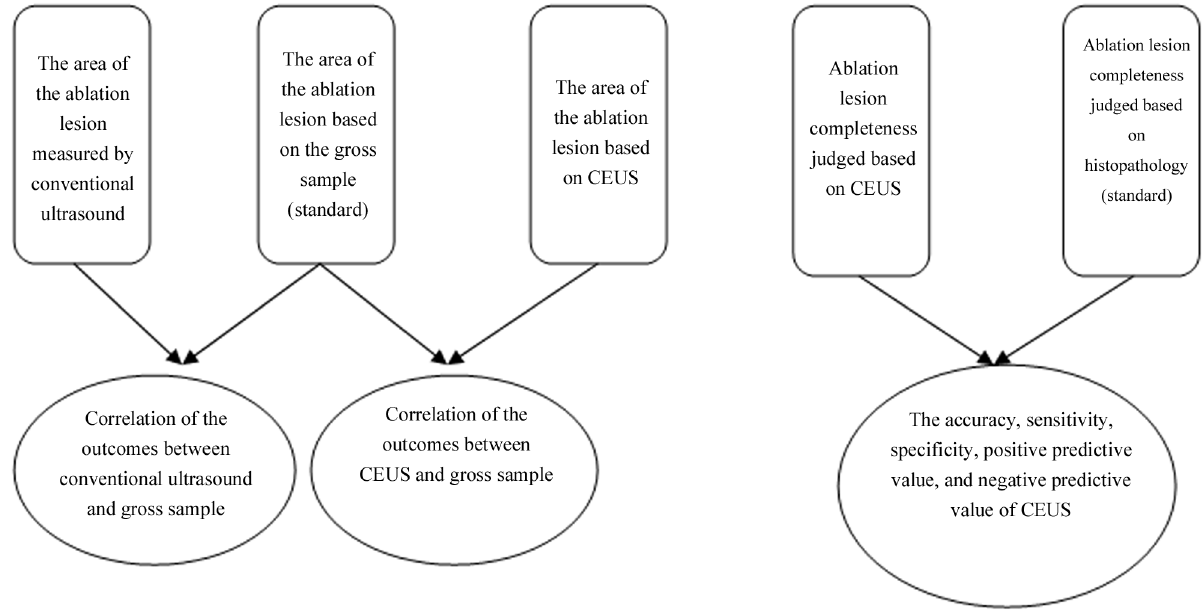
Figure 1. Flowchart of the experimental design of this